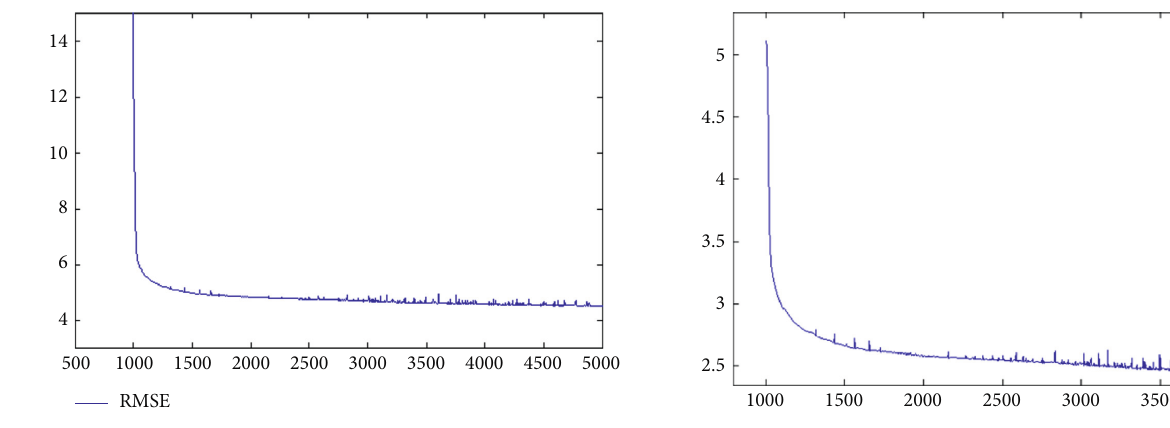
Figure 11: RNN-GCN RMSE diagram.